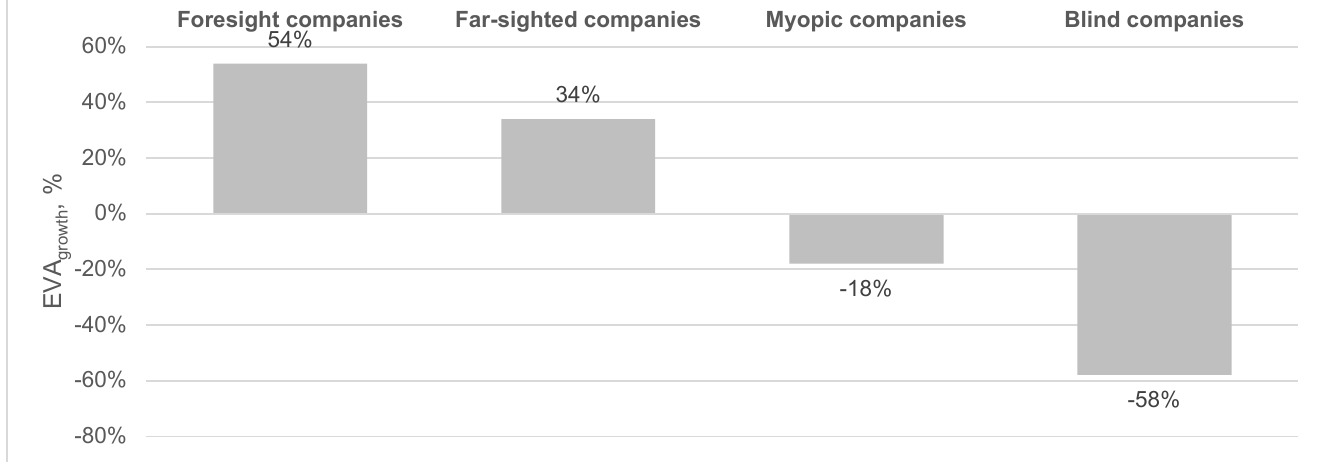
Figure 3. Correlation between SKRI and multi-period average growth of economic value added.